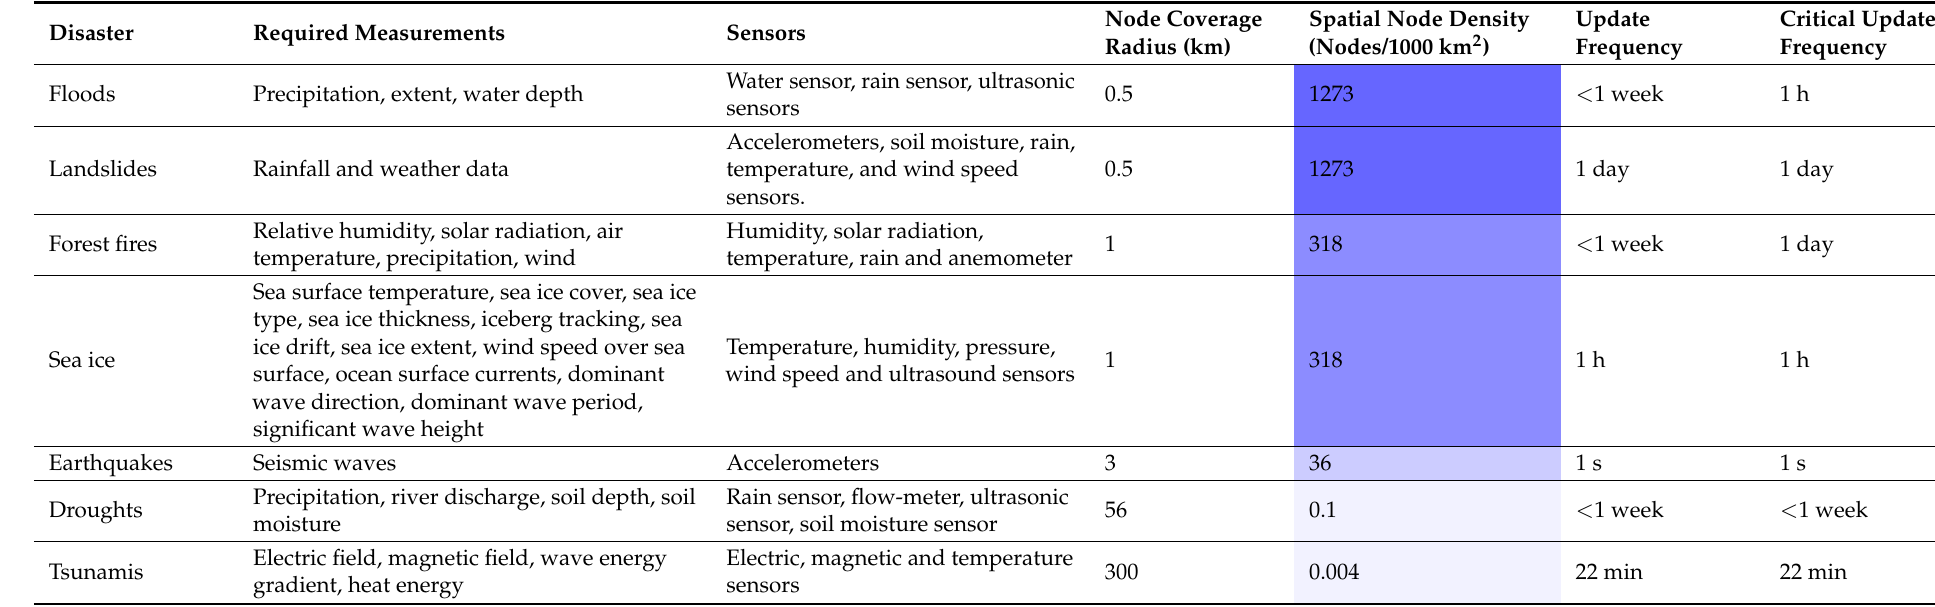
Table 1. Summary of required measurements, sensors used, spatial node density, and update frequency for the cases